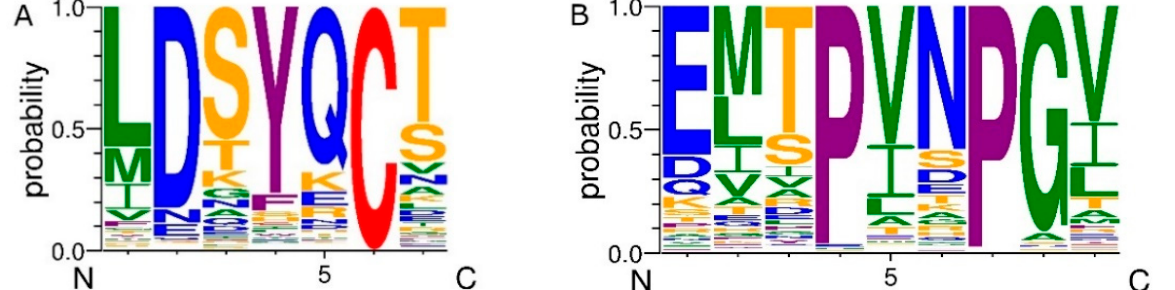
Figure 2. WebLogo representation of amino acid abundances at each position of ( A ) AFP 14–20 -like and ( B ) GIP-9-like motifs identified in proteins retrieved from UniProtKB database. The overall height of every stack indicates residue conservation at each position, while a symbol height within the stack indicates relative frequency of each residue at that position. Colors of symbols are as follows: hydrophobic and glycine—green, hydrophilic and positively charged—orange, negatively charged and their amides—blue, aromatic plus proline—purple, and cysteine—red.